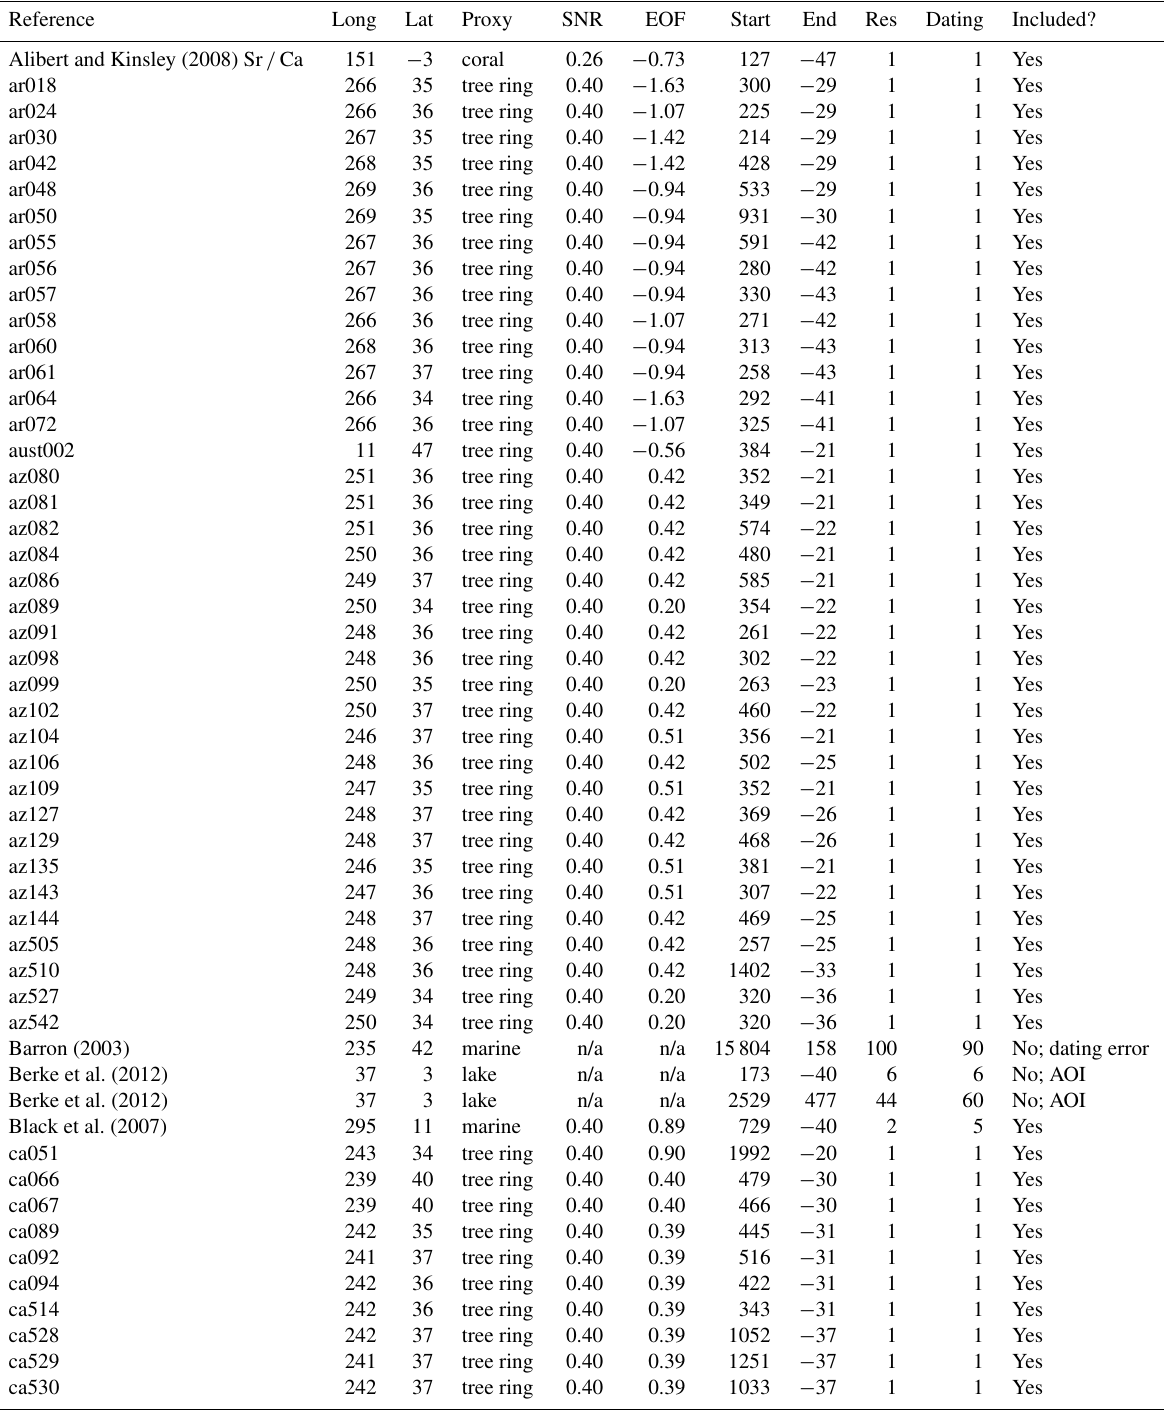
Table A2. Precipitation proxy details. “SNR” gives the signal-to-noise ratio used to make the pseudo-proxies. “EOF” gives the (unscaled) 20CRV2c EOF value used to weight the proxy. “Start” and “End” are starting and ending years in years BP. “Res” is proxy resolution, rounded to the nearest integer; sub-annual proxies are listed as having a 1-year resolution. “Dating” refers to dating error. “Included?” indicates whether the proxy contributed to the final ENSO reconstruction; if not, the reason for exclusion is listed (“Dating error” and “Length” are a priori conditions, which the proxies failed to meet. “AOI” indicates it passed preprocessing screening, but was not selected during the add-one-in